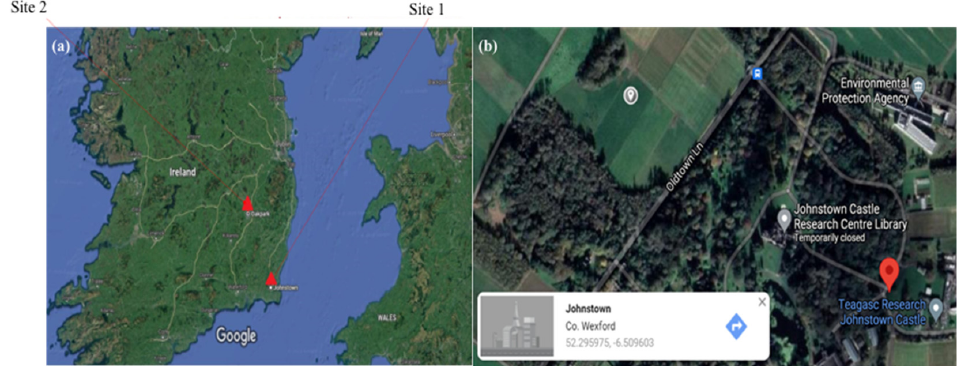
Figure 1. ( a ) Site locations in Republic of Ireland; ( b ) field sampling location of site 1, 52.295957 N & -6.509603 W, source Google maps.